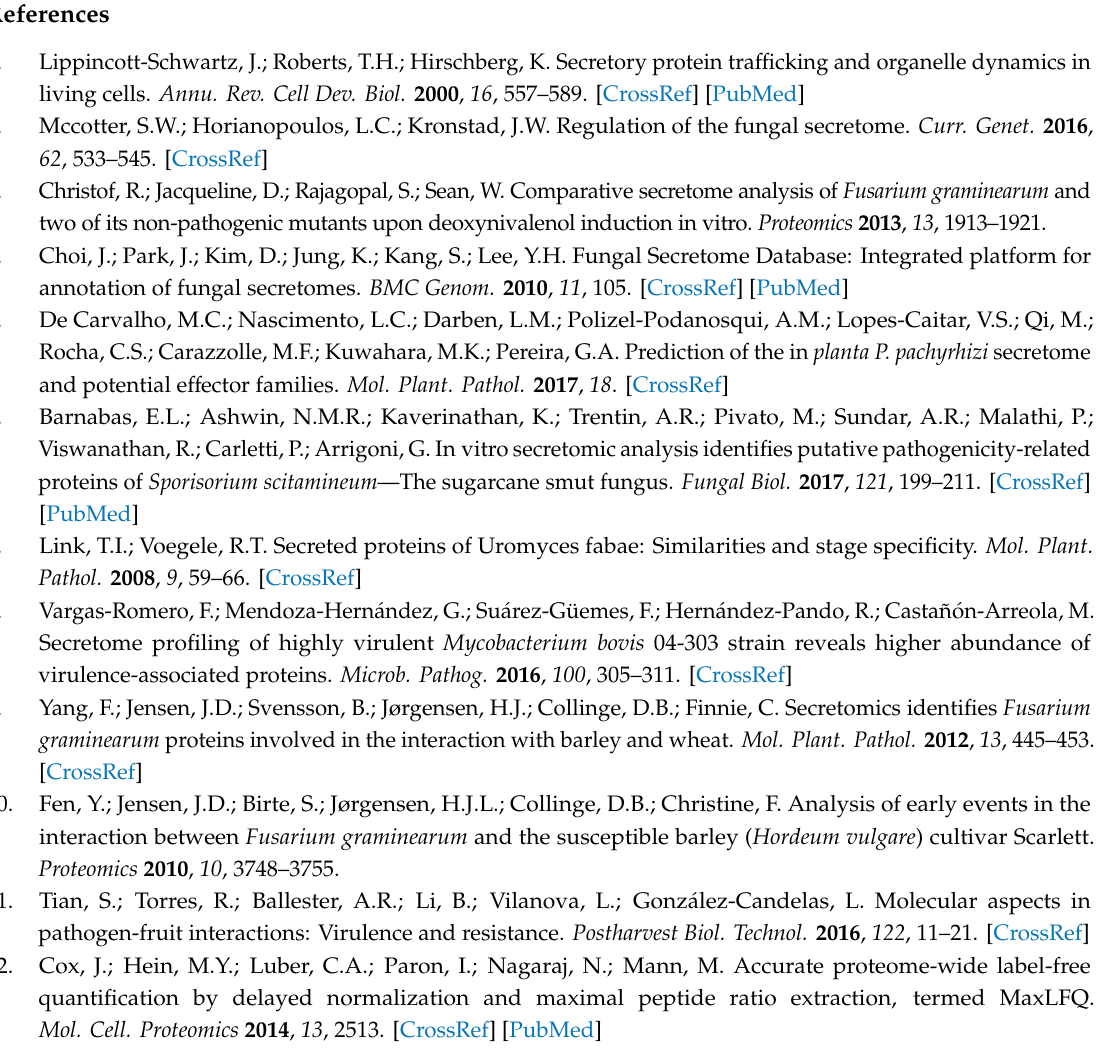
Figure S1: The evaluation results of the identification and quantitation of proteins in F. proliferatum cultured with and without banana peel; Figure S2: Visual picture of Fusarium proliferatum infection on banana fruit; Table S1: Detailed information for identified secreted proteins in this study; Table S2: Details for protein LFQ parameters; Table S3: Primers used for qRT-PCR in this